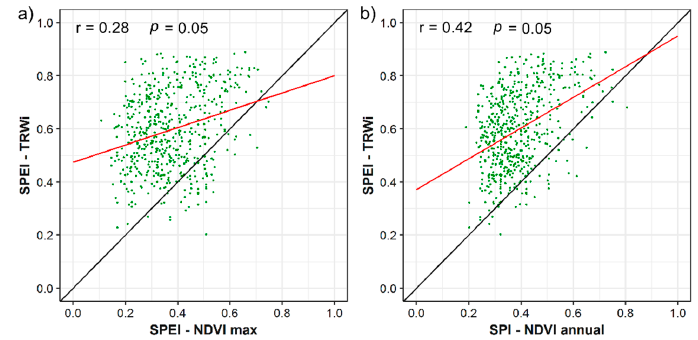
Figure 4. Scatterplots showing maximum Pearson correlation coefficients found for SPEI-TRWi and SPI-NDVIannual ( a ) and SPEI-TRWi and SPEI-NDVImax ( b ). The solid red line corresponds to the fitted linear regression model and black line, 1:1.